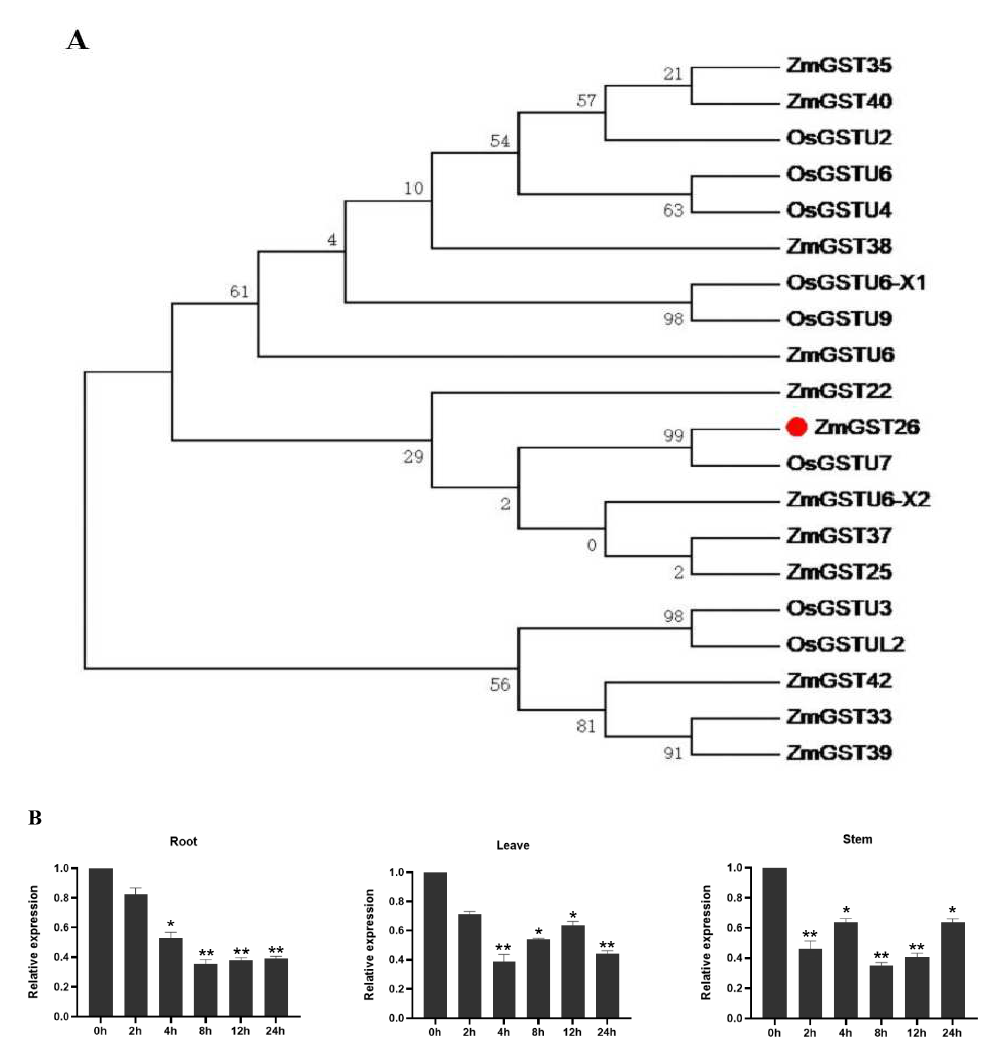
Figure 1. Phylogenetic analysis and expression pattern analysis of ZmGST26 . ( A ) Phylogenetic analysis of the Tau class of Glutathione S-transferases. ( B ) Expression of ZmGST26 in roots, leaves and stem of maize at different time under drought stress. ( ZmActin1 was used as an internal reference gene). * p < 0.05; ** p < 0.01. All bars represent means ± SD, (n ≥ 3).